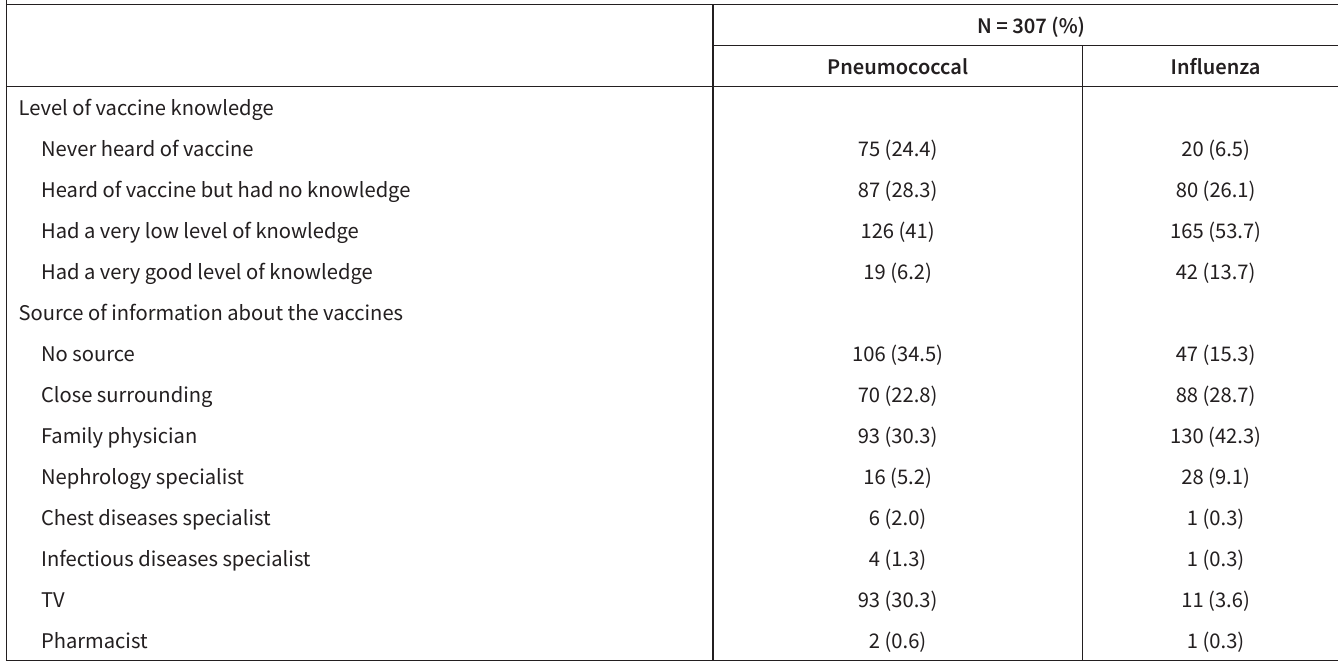
Table 4. The Patients’ Level of Knowledge of the Pneumococcal and Influenza Vaccines and Their Source of Information